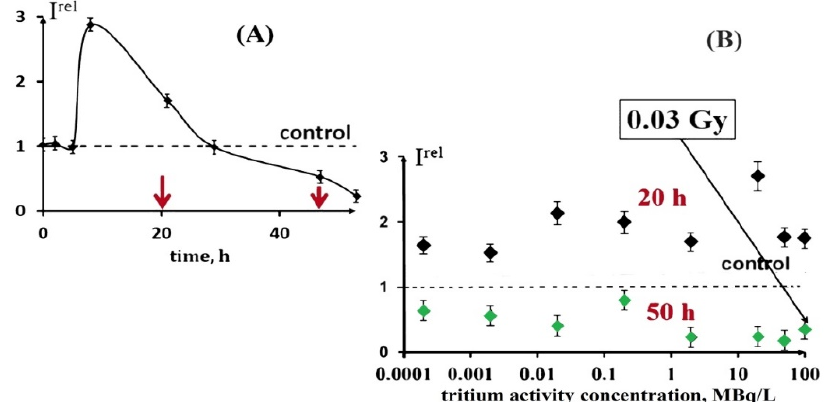
Figure 1. Effect of tritiated water on the bioluminescence of bacteria [47,48]. ( A ) Bioluminescence kinetics of bacteria in tritiated water, 2 MBq · L − 1 ; the red arrows denote the times of exposure (20 and 50 h); ( B ) bioluminescence intensity vs. activity concentration of tritiated water at 20 h (black) and 50 h (green) exposures.